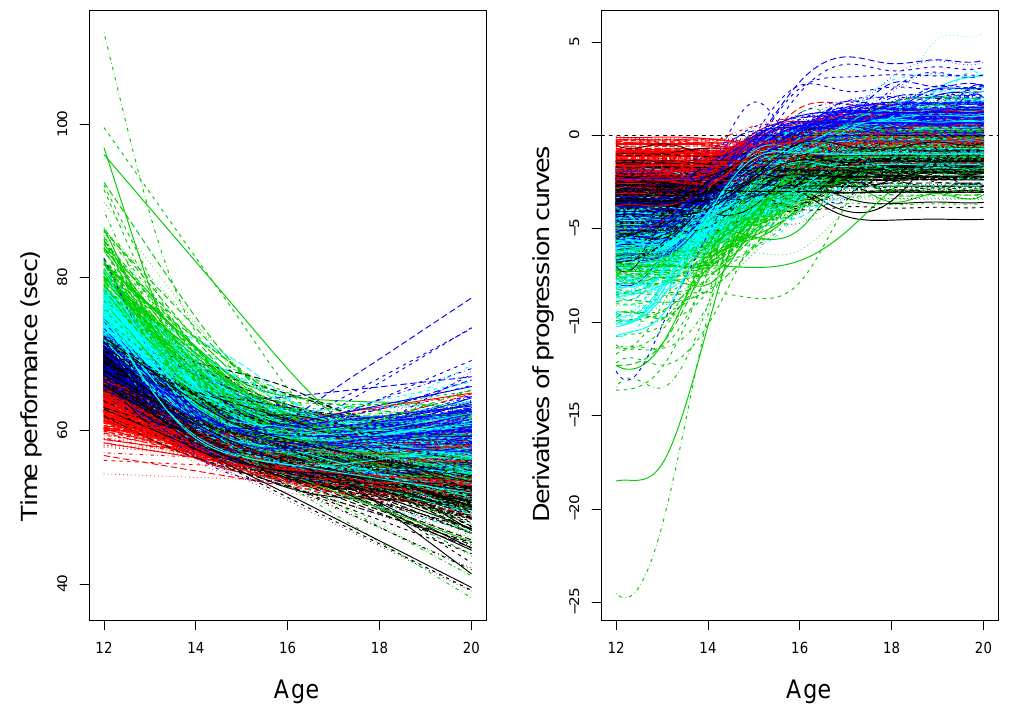
Figure 5. All progression curves of swimmers ( left ) and derivatives ( right ) coloured by clusters, obtained with the multivariate funHDDC algorithm. ( Left ) each curve represents the time performance for one swimmer between 12 and 20 years old. The clustering by level of performance can be observed particularly in this graph. ( Right ) each curve represents the derivative of the progression curve for one athlete between 12 and 20 years old. The clustering by speed of improvement and progression patterns is more clearly expressed in this